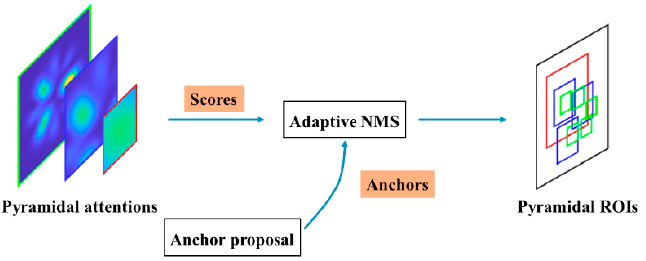
Figure 2. Workflow of the weakly supervised region proposal generator.